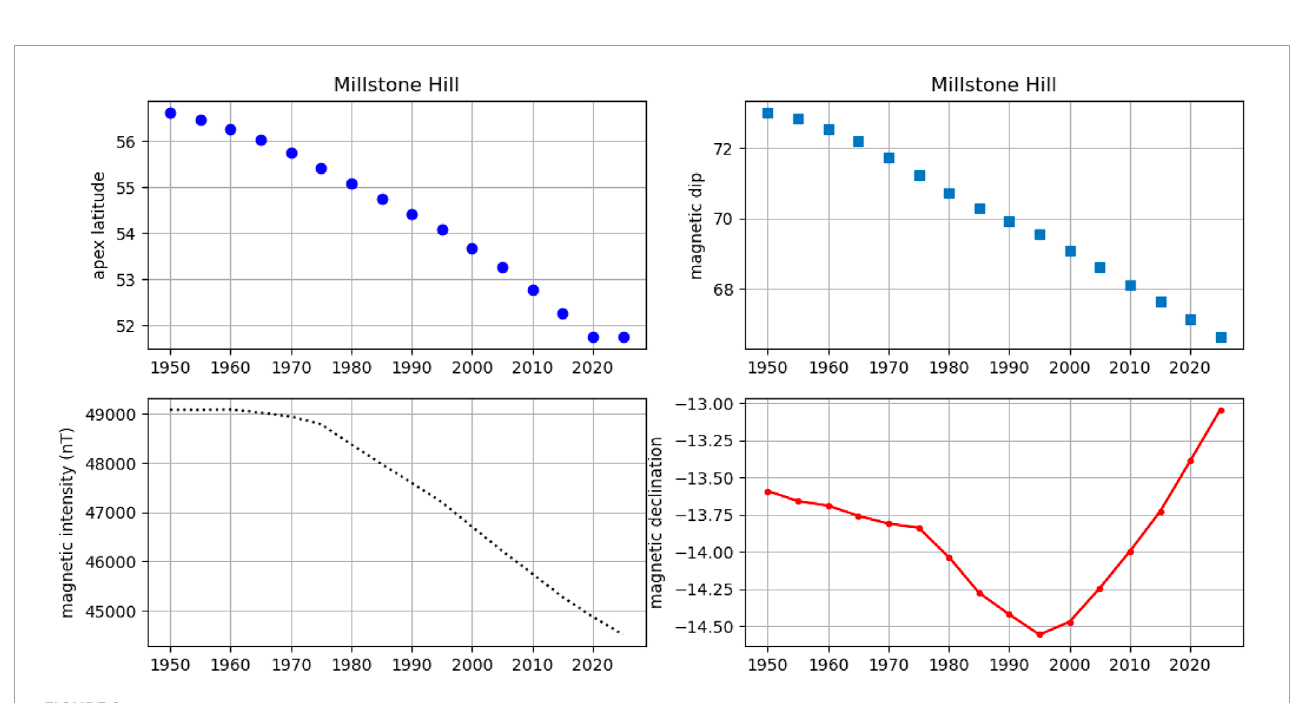
FIGURE 2 Long-term variations of the main magnetic field at Millstone Hill based on the IGRF